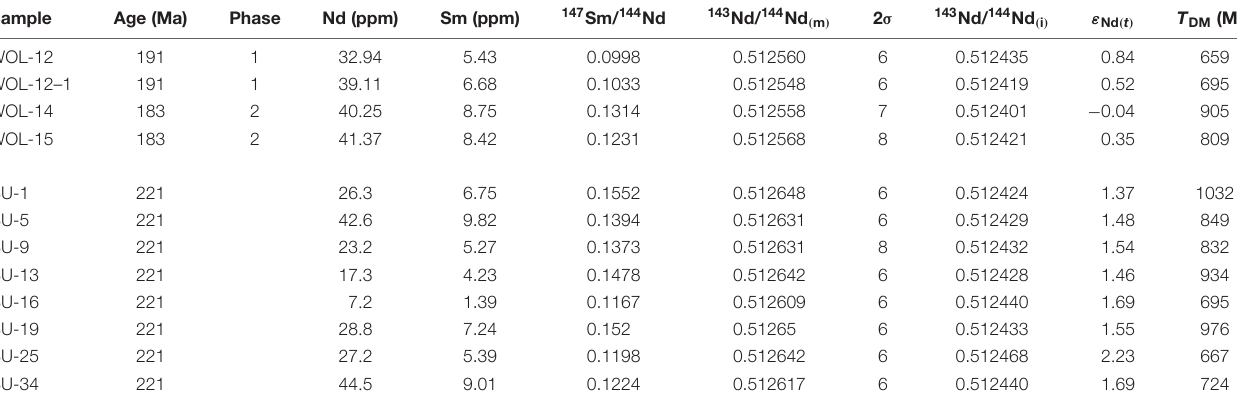
TABLE 2 | Nd isotopic composition of granitic rocks of the TSP and BU intrusions.